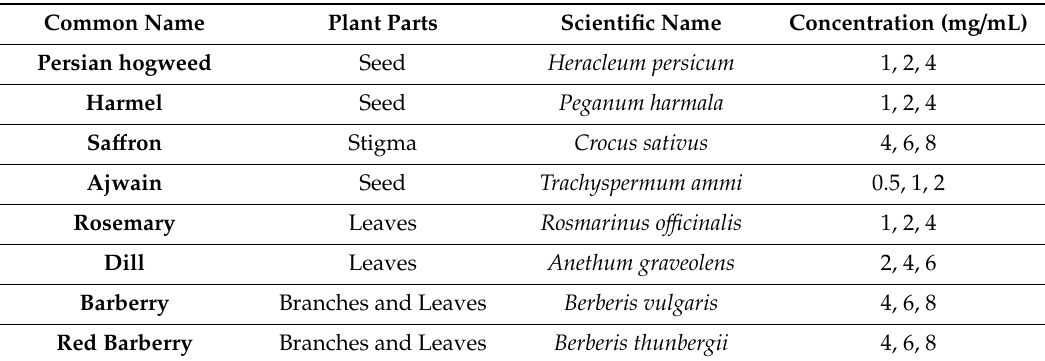
Table 3. Selective concentrations for each